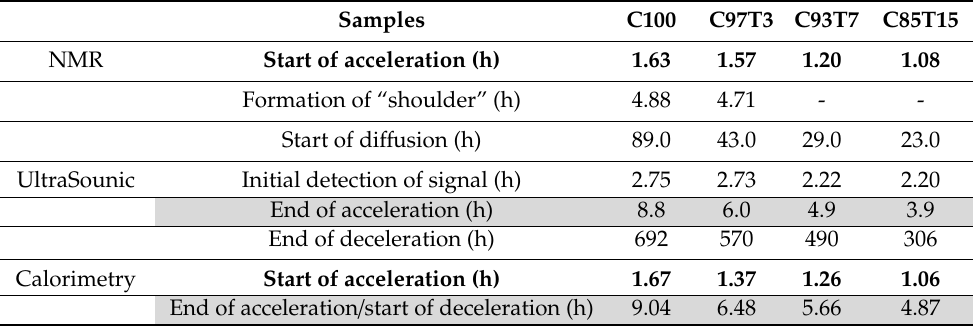
Table 2. Periods of the hydration process for all four samples.